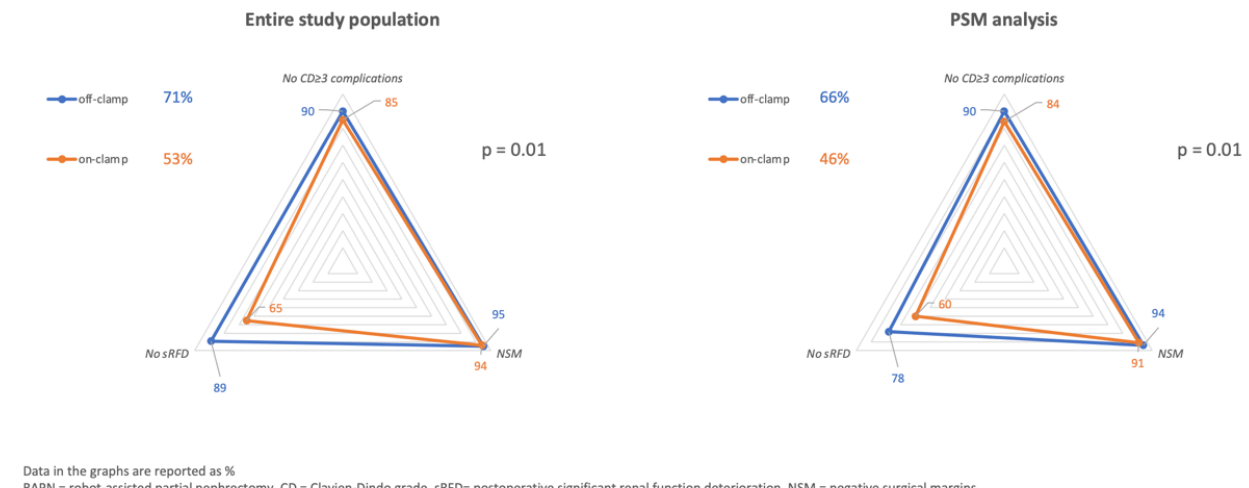
Figure 1. Trifecta rates, according to the clamping technique.